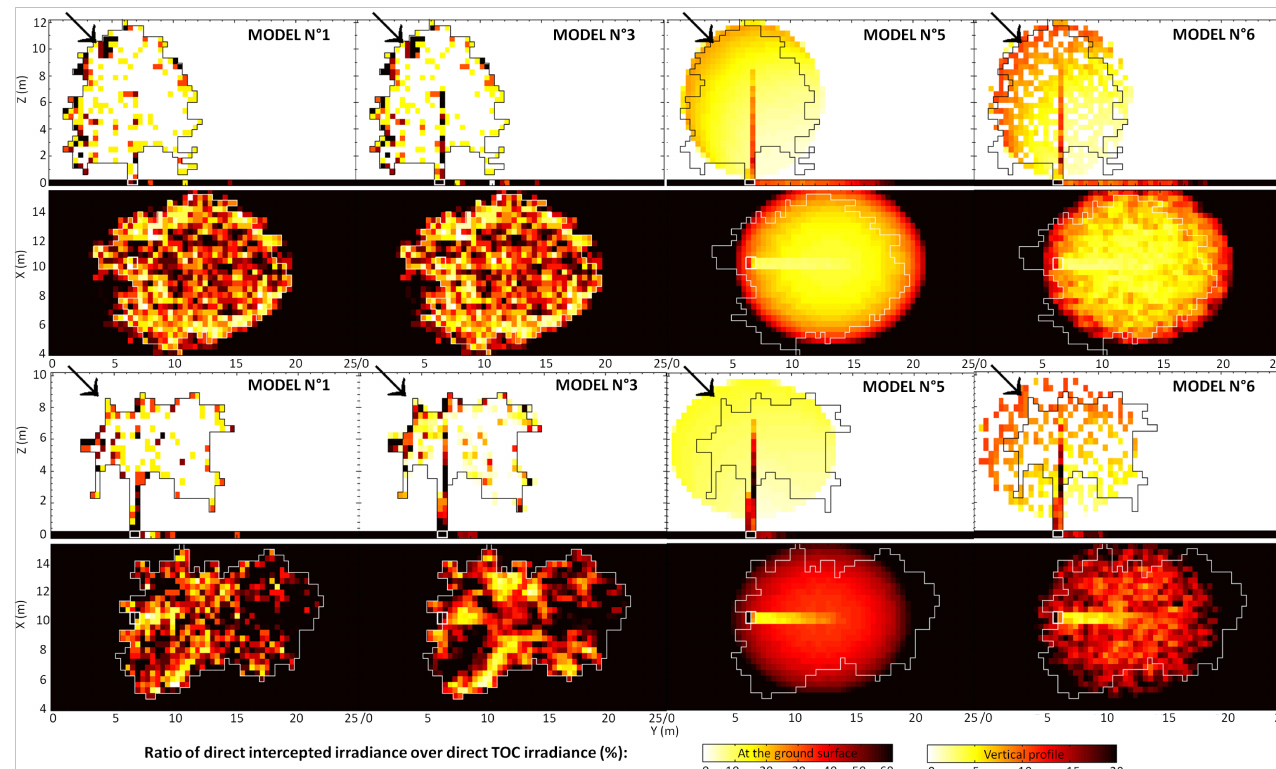
Figure 9. Ratio of the direct intercepted irradiance over the direct I TOC through a vertical profile at X = 10 m (first/third rows) and T dir computed at the ground surface Z = 0 m (second/fourth rows) for the linden (two first rows) and magnolia trees (two last rows) at 0.8 µ m (SZA = 45 ◦ and BACKGROUND = grass; solar direction indicated by the black arrow, crown spatial extents delineated in black, shadow and trunk location in